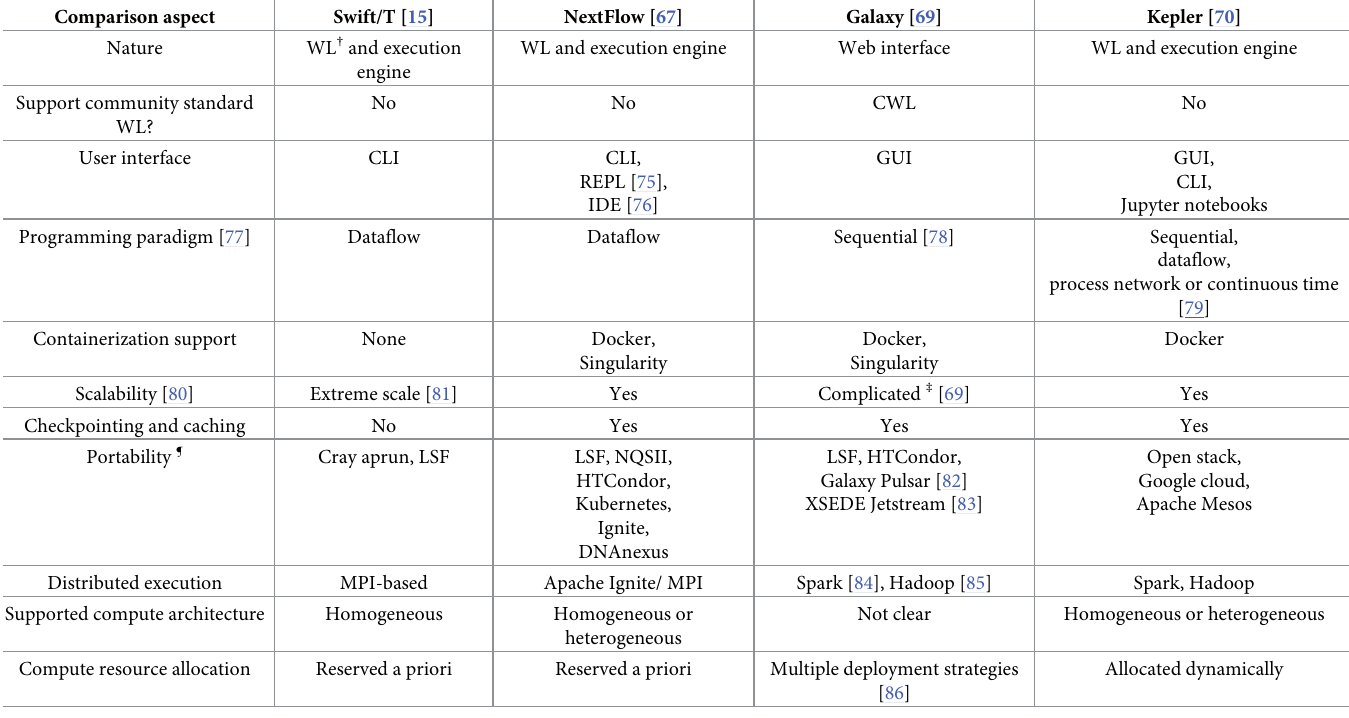
Table 3. Popular workflow management